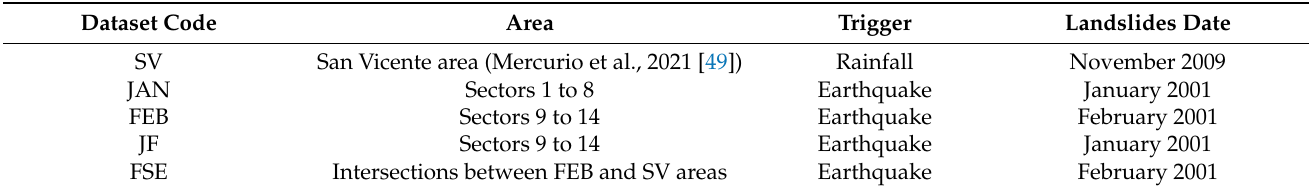
Table 4. Datasets used to calibrate and validate the landslide predictive models.